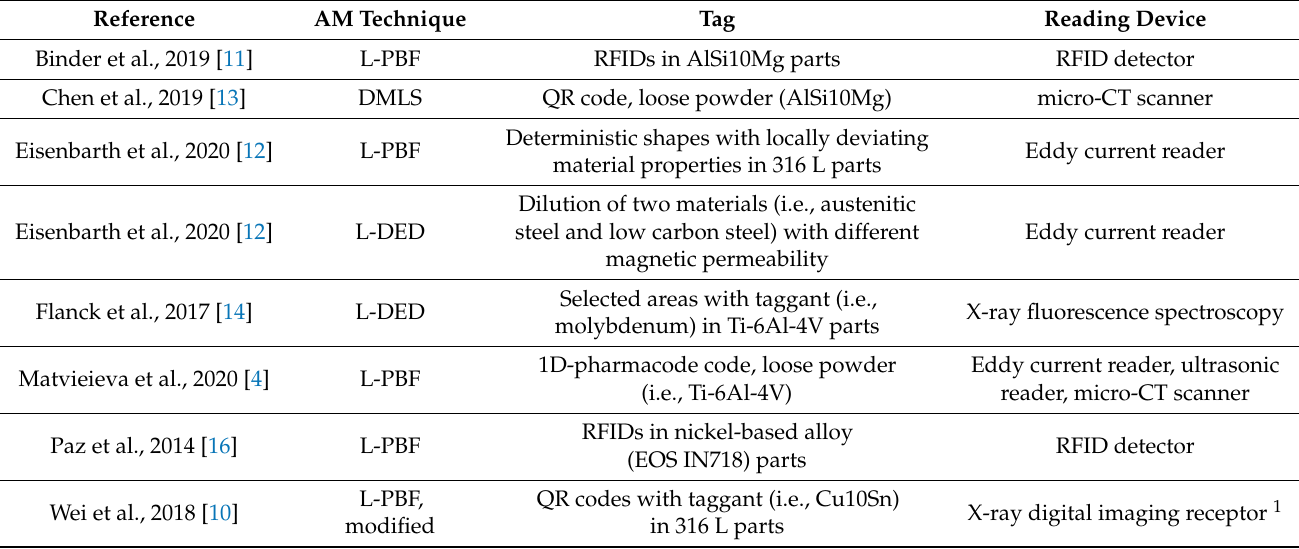
Table 2. Summary of tagging strategies demonstrated in the literature for metal-based AM parts